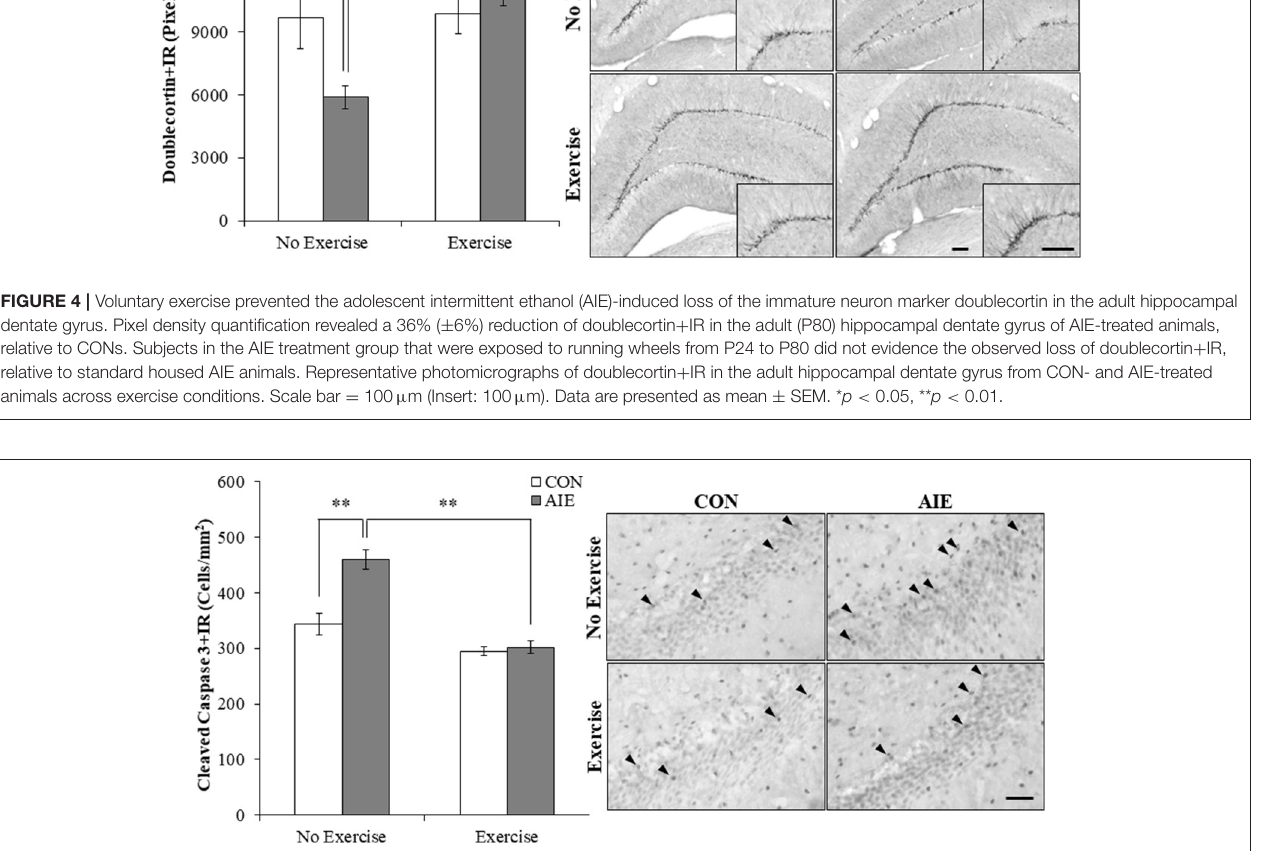
FIGURE 5 | Running wheel exposure prevented the adolescent intermittent ethanol (AIE)-induced increase of the cell death marker cleaved caspase 3 in the adult hippocampal dentate gyrus. Modified unbiased stereological quantification revealed a 34% ( ± 5%) increase of cleaved caspase 3 + IR cells in the adult (P80) hippocampal dentate gyrus of AIE-treated animals, relative to CONs. Voluntary wheel running from P24 to P80 prevented the AIE-induced increase of cleaved caspase 3 + IR cells, relative to AIE animals. Representative photomicrographs of cleaved caspase 3 + IR cells in the adult hippocampal dentate gyrus from CON- and AIE-treated animals across exercise conditions. Scale bar = 50 µ m. Data are presented as mean ± SEM. ** p <